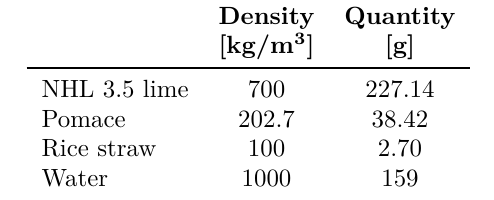
Figure 4. Prototype